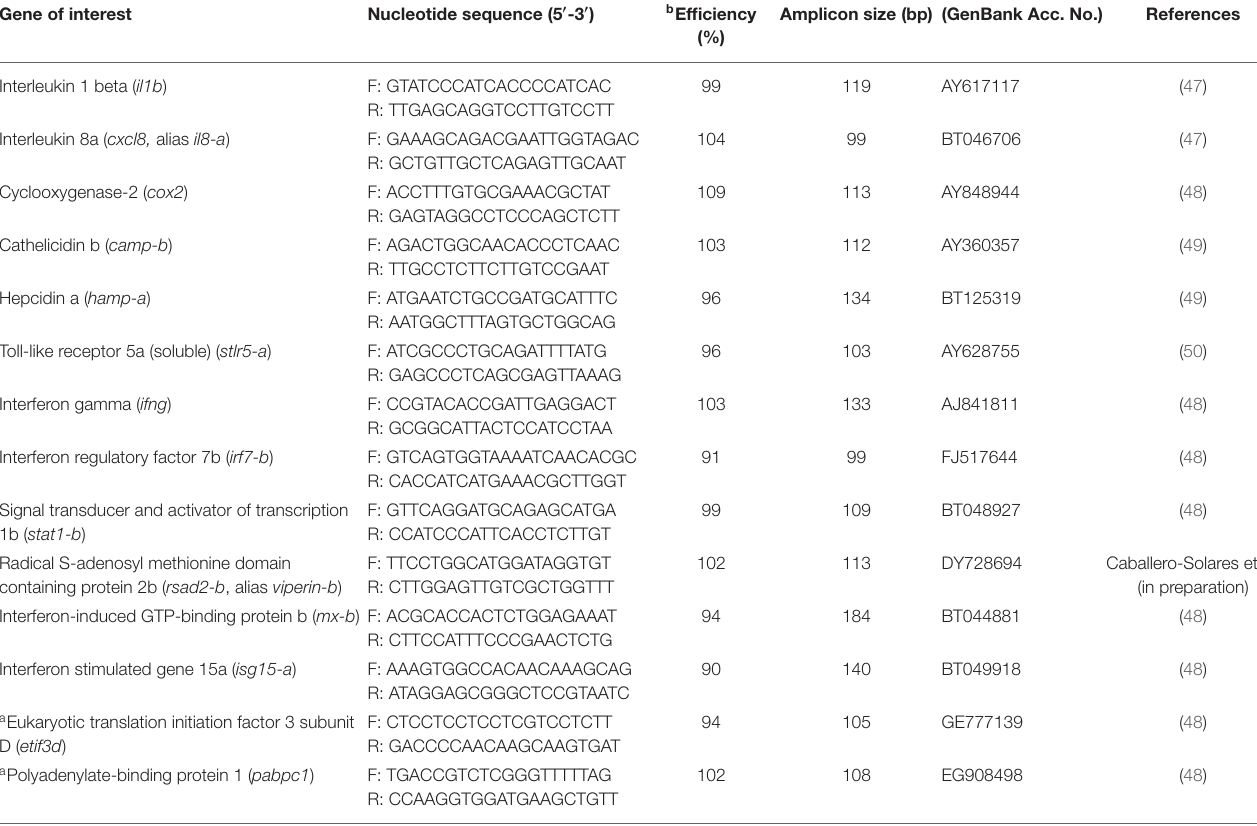
TABLE 1 | Primers used in the Real-time quantitative polymerase chain reaction (qPCR) analyses. Gene of